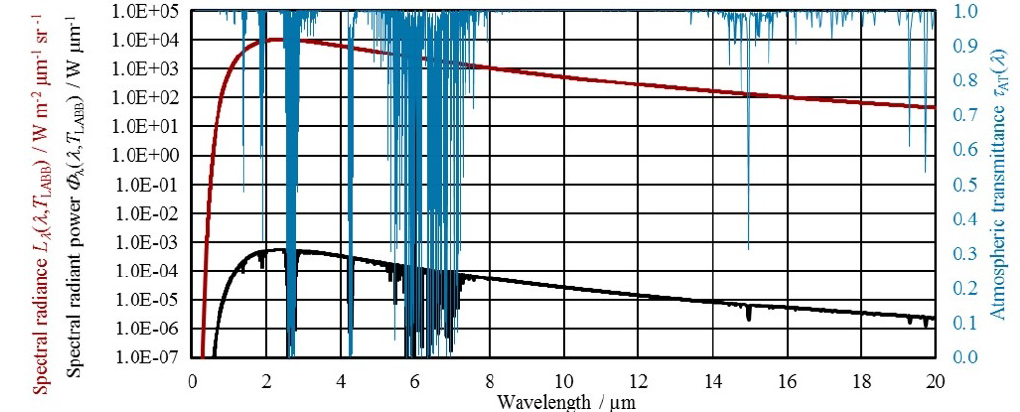
Figure 3. The spectral radiance L λ ( λ , T LABB ) of the LABB as given by Planck’s law for a temperature of 1200K (red), the transmittance of 400mm atmosphere τ AT ( λ ) (blue) and the obtained spectral radiant power (cid:56) λ ( λ , T LABB ) for the geometry at the calibration setup